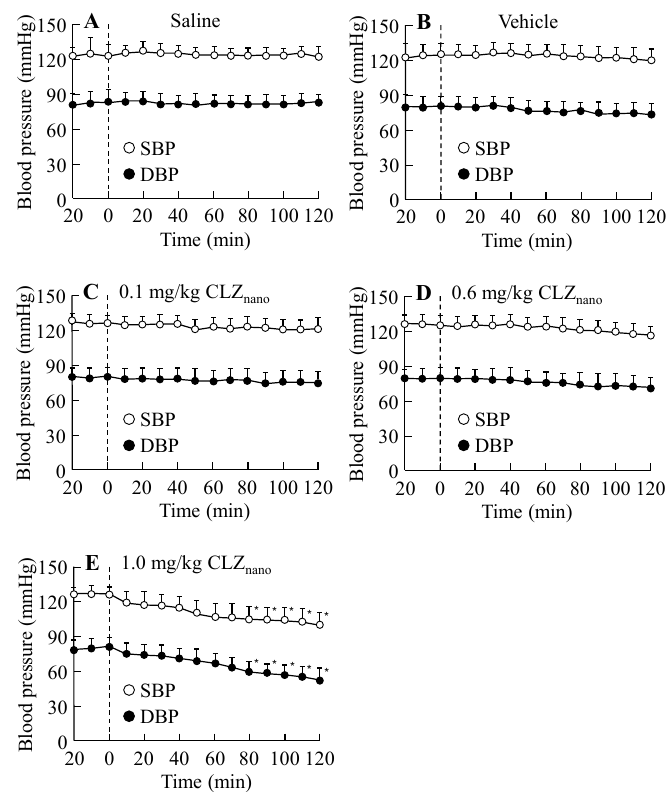
Figure 4. Changes in blood pressure following the intravenous injection of CLZ nano dispersion. Saline ( A ); vehicle ( B ); 0.1 mg/kg CLZ nano ( C ); 0.6 mg/kg CLZ nano ( D ) or 1.0 mg/kg CLZ nano ( E ) dispersion was injected into the tail vein. The rats were anesthetized with Urethane (1.2 g/kg, i.p.), and the systolic blood pressure (SBP, open circles) and diastolic blood pressure (DBP, closed circles) were measured using a transducer (DX312) for 140 min (11:00–13:20). CLZ was injected 20 min after the first measurement (0 min). The data are presented as means ± S.E. of seven independent rats. * p < 0.05, vs. blood pressure at 0 min for each category.